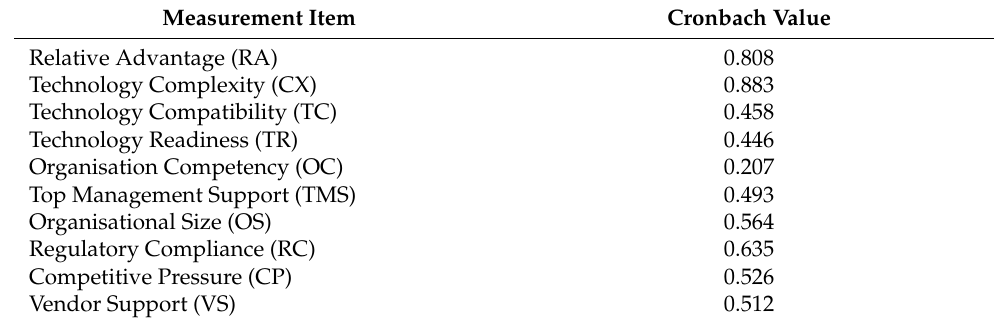
Table 9. Cronbach measurement per item.